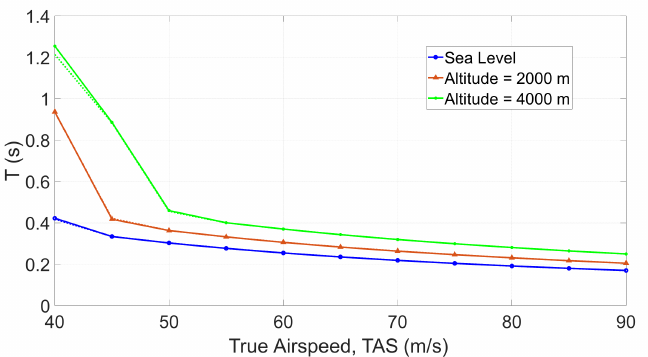
Figure 17. Time to double amplitude versus various airspeeds for roll mode; (solid lines account for optimization using mass minimization scenario and dotted-lines are for drag optimization in trim flight).